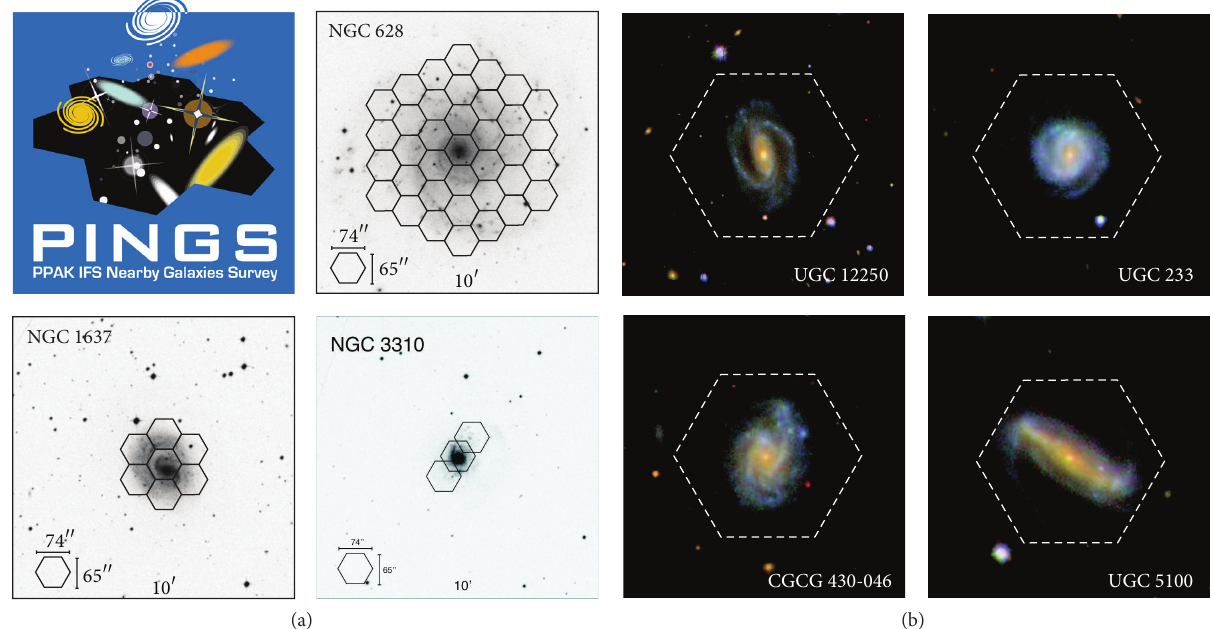
Figure 1: (a) Examples of the PINGS IFS mosaics, each panel shows a 𝐵 -band Digital Sky Survey image of the galaxy with the PPAK mosaic pointings as overlaid hexagons indicating the FoV of the central fibre bundle. (b) Examples of the face-on spirals drawn from the M´armol- Queralt´o et al. [21] sample of IFS galaxies, each panel shows a colour-composite SDSS image of the galaxy with the PPAK FoV footprint